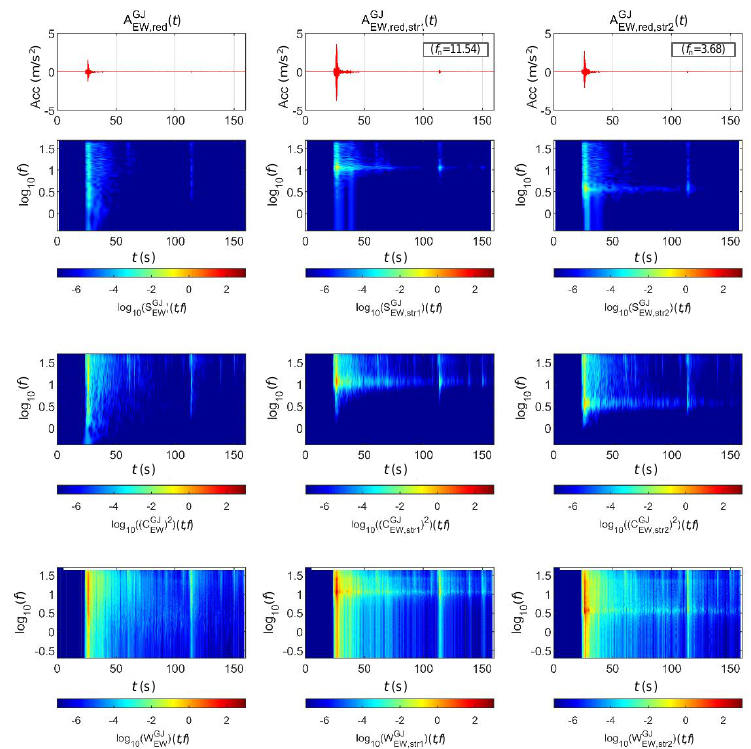
Figure 14. Analysis Results of the Gyeongju earthquake data (scaled for 2400-year return period) and associated bridge responses.